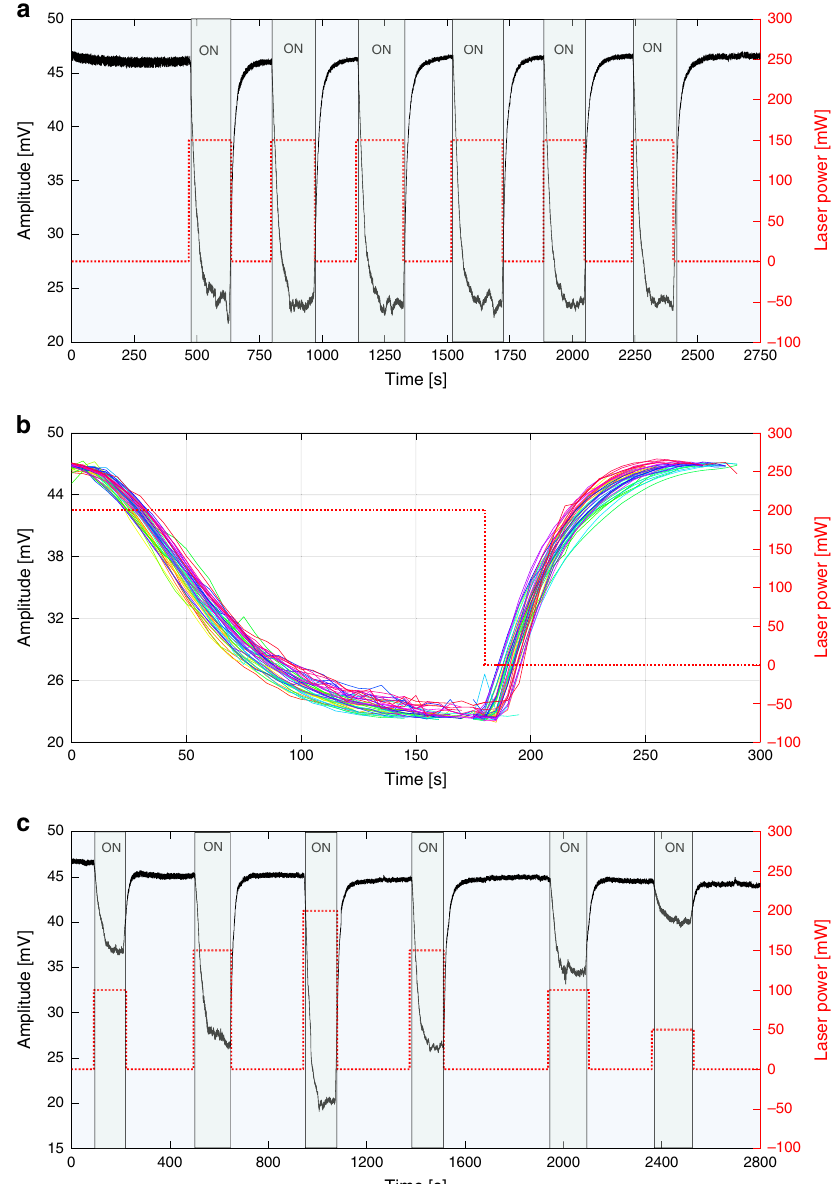
Fig. 3 Photo-switchable elastic fi lter. a Amplitude of the elastic wave transmitted through the LRMM during 6 on-off illumination cycles with a 150 mW laser power. b Temporal trace of the on-off switching over 100 cycles. The effect is reversible, with the recovery dyamics being described by a mono- explonential function with a τ ≃ 67 s time constant. Different colors represent different repetitions of the same on-off cycle (only 50 cycles are reported for clarity). c Light-induced modulation of the transmitted acoustic wave amplitude at several illumination power levels. All measurements are performed at a frequency of 95 kHz, at the upper frequency edge of the light-induced band gap